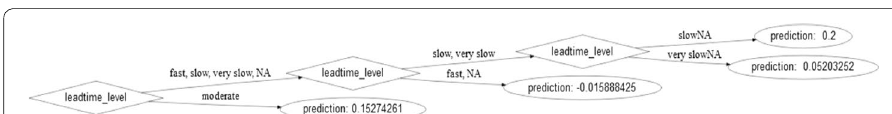
Fig. 11 GBM model’s lead time distribution for backorder class